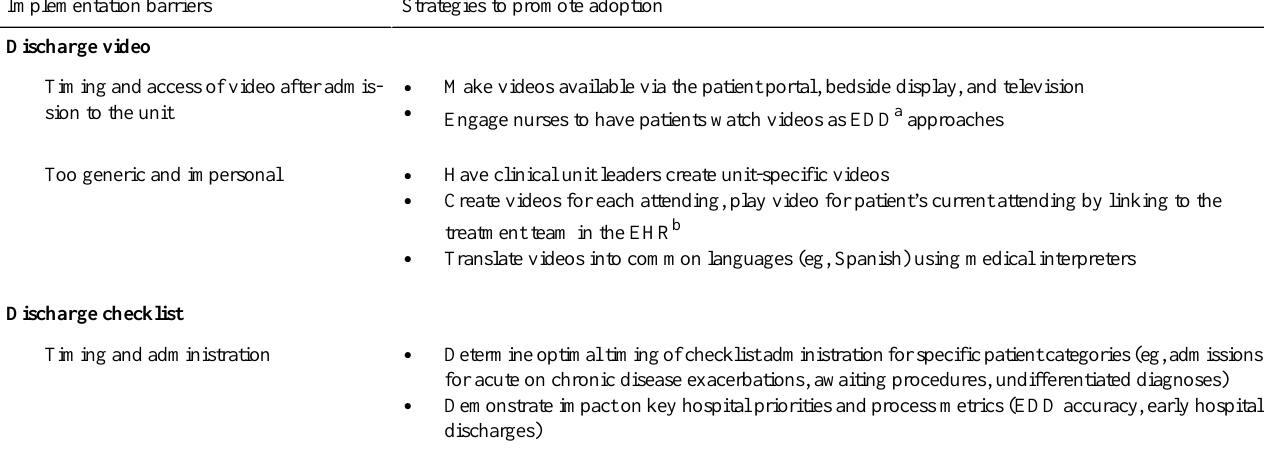
Table 6. Implementation barriers and strategies to promote